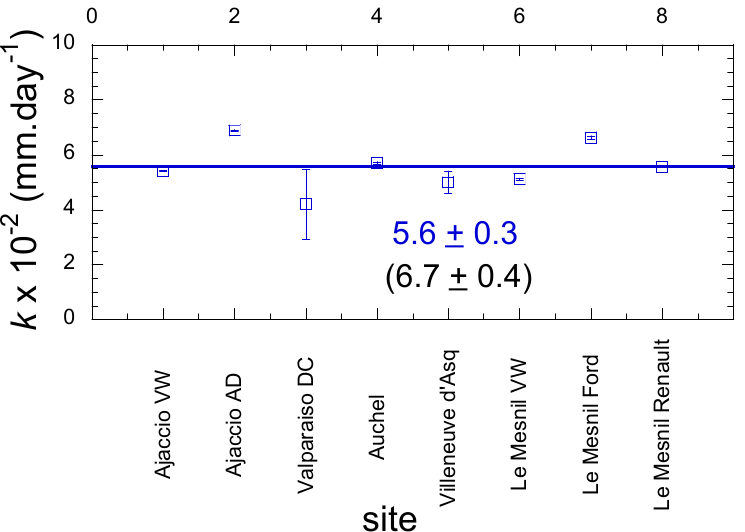
Figure 19. Values of factor k between dew yield on a thermally isolated horizontal plane and from the observation scale (Equations (1) and (43)–(45)) as a function of measurement site and type of car. The mean value k = 0.056 ± 0.003 mm · day − 1 is indicated with one standard deviation uncertainty. The value under the bracket is for comparison with a thermally isolated 30 ◦ inclined plane and corresponds to K = 1.2 k = 0.067 ± 0.0036 mm · day − 1